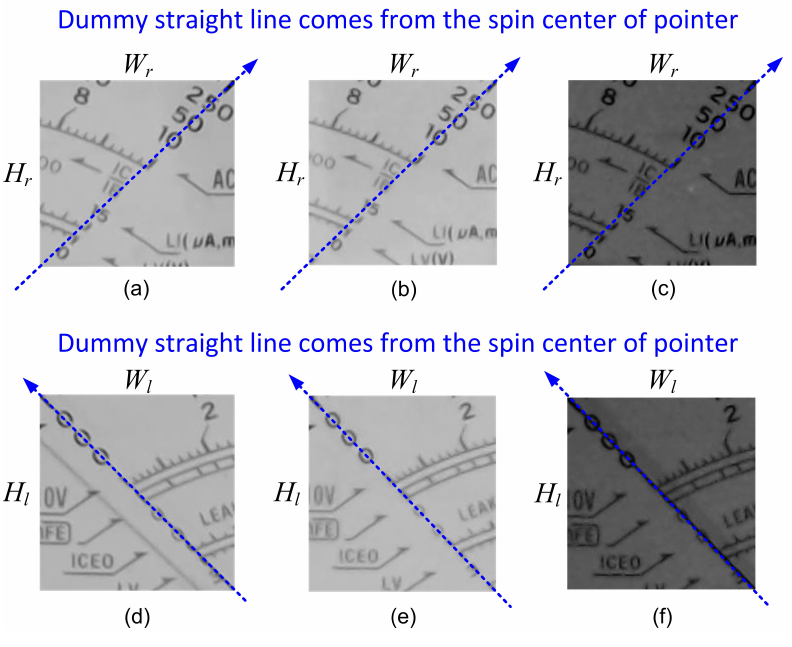
Figure 10. ( a – c ) illustrate that the templates, T EGM , T PGM and T PGM , given right-end bright-right-end dark-right-end respectively in Figure 7d–f ,were selected with a W r × H r rectangular ROI so that one pair of diagonal corner points were just passed over by a dummy straight line of the right-end scale; ( d – f ) illustrate that the templates, T EGM , T PGM and T PGM , given respectively in Figure 7g–i, were selected left-end bright-left-end dark-left-end with a W l × H l rectangular ROI so that one pair of diagonal corner points were just passed over by a dummy straight line of the left-end